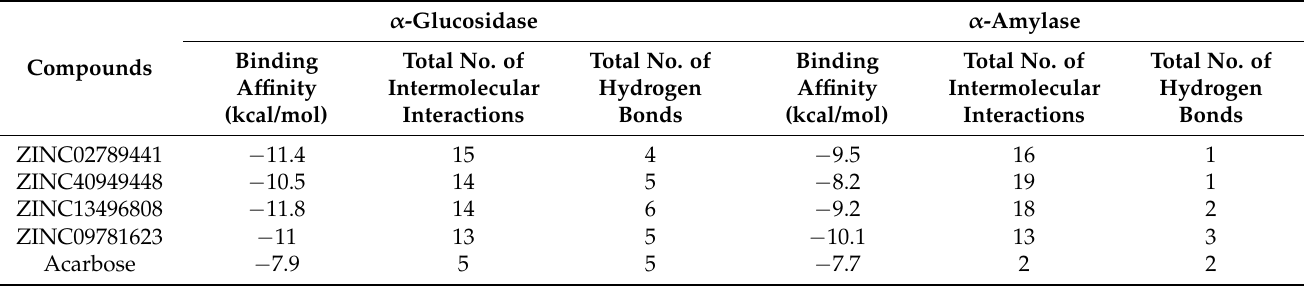
Table 7. Selected potential dual inhibitors for α -glucosidase and α -amylase from the virtual screening of pharmacophore